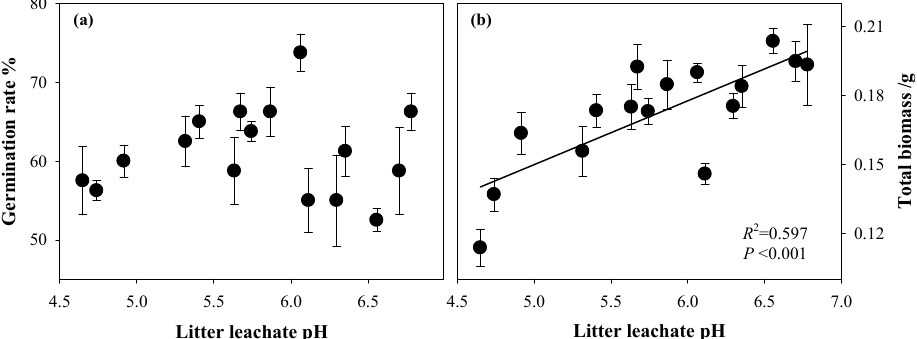
Figure 4. Relationships between the litter leachate pH from different forest types and Phytolacca americana ( a ) seed germination and ( b ) biomass accumulation. Bars indicate standard errors of several replicates.